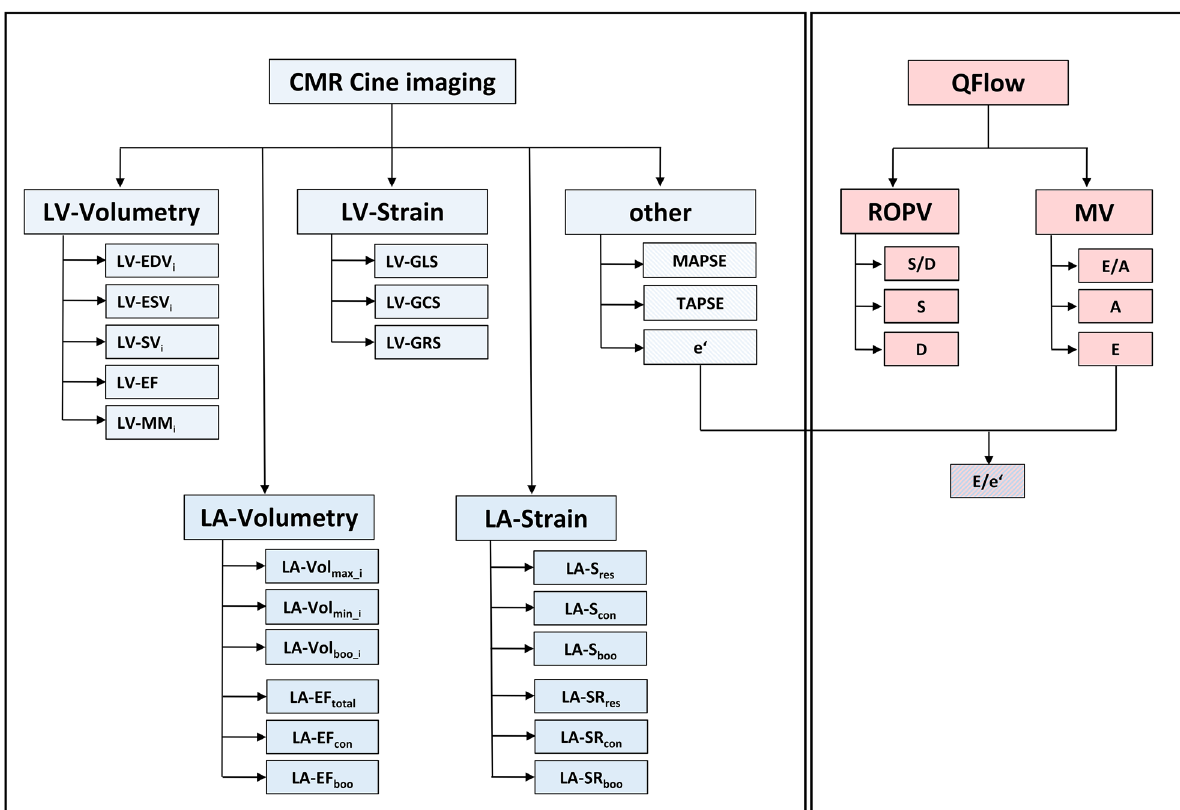
Figure 4. Overview of measures for investigation of the correlations between left atrial strain/strain rate and volumetric, hemodynamic and functional parameters. Left atrial and left ventricular volumetric data as well as strain/strain rate values were calculated using cine cardiovascular magnetic resonance (CMR) imaging. Systolic and diastolic functional parameters were obtained applying quantitative blood flow measurements (QFlow). LA-S res reservoir left atrial strain, LA-S con conduit left atrial strain, LA-S boo booster left atrial strain, LA-SR res reservoir left atrial strain rate, LA-SR con conduit left atrial strain rate, LA-SR boo booster left atrial strain rate, LA-Vol max_i indexed maximum left atrial volume, LA-Vol min_i indexed minimum left atrial volume, LA-Vol boo_i indexed booster left atrial volume, LA-EF total total left atrial ejection fraction, LA-EF con passive left atrial ejection fraction, LA-EF boo booster left atrial ejection fraction, LV-EDV i indexed left ventricular end diastolic volume, LV-ESV i indexed left ventricular end systolic volume, LV-SV i indexed left ventricular stroke volume, LV-EF left ventricular ejection fraction, MM i BSA-indexed muscle-mass, LV-GLS global left ventricular longitudinal strain, LV-GCS global left ventricular circumferential strain, LV-GRS global left ventricular radial strain, MAPSE mitral annulus plain systolic excursion, TAPSE trikuspidal annulus plain systolic excursion, S/D ratio S-wave to D-wave by quantitative right upper pulmonary vein blood flow measurements, E/A ratio E-wave to A-wave by quantitative transmitral blood flow measurements, E E-wave by quantitative transmitral blood flow measurements, A A-wave by quantitative transmitral blood flow measurements, é mean lateral and septal cine CMR velocities, E/é ratio E-wave to